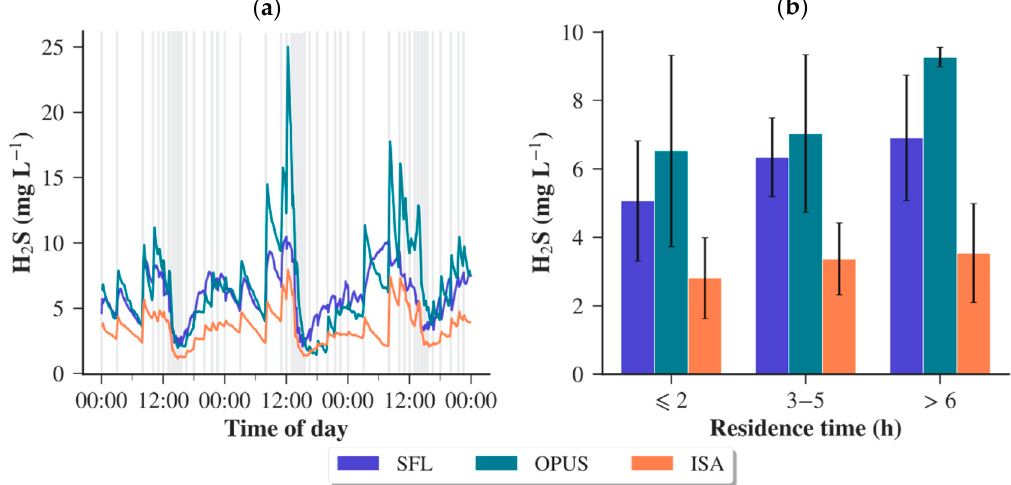
Figure 3. Diurnal hydrogen sulfide profiles during intermittent wastewater pump operation ( a ). Influence of the residence time on the H 2 S concentration ( b ). Error bars show the standard deviation of the mean H 2 S concentration for each residence time group ( ≤ 2 h, 3–5 h & >6 h).